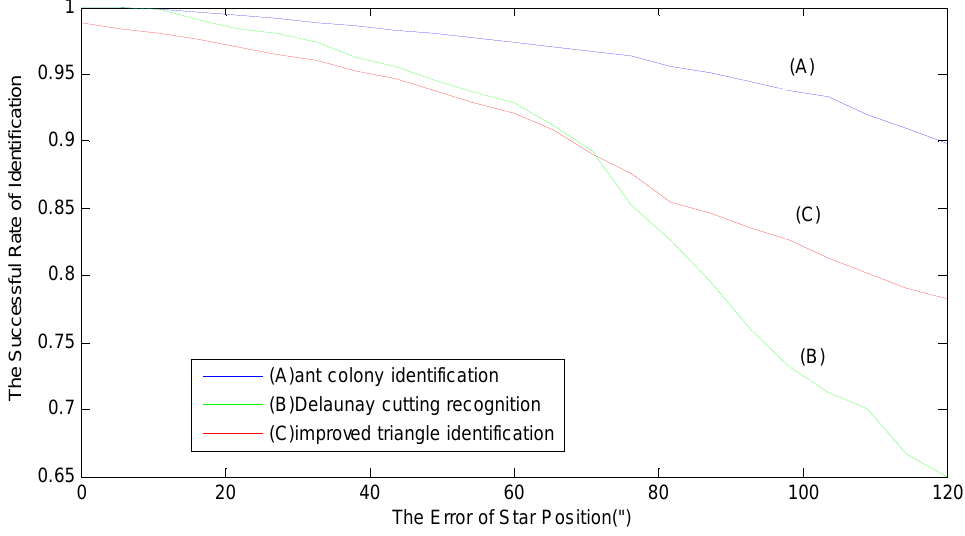
Figure 4. Relationship between star position error and success rate of